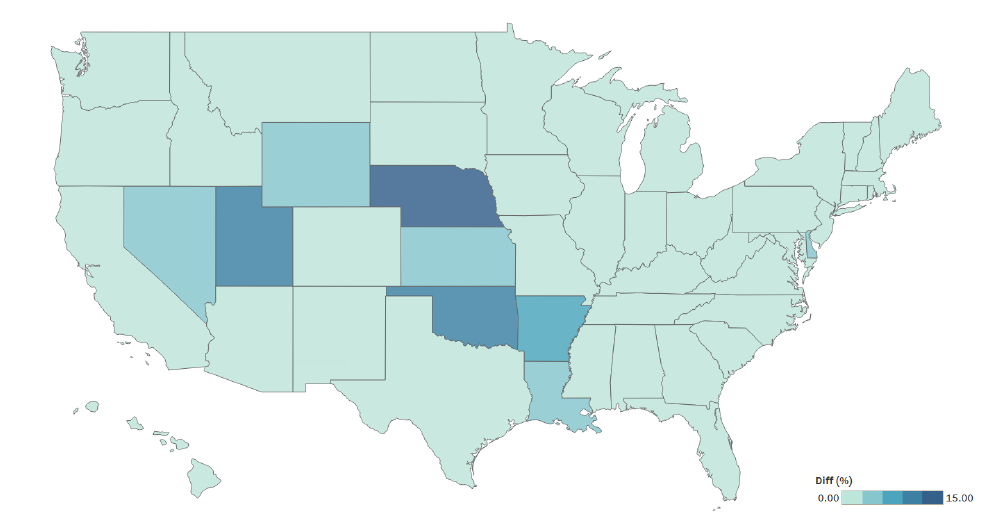
Figure 7. Absolute relative differences (%) between state-level survey and model point estimates for the hours per week of all hired agricultural workers.